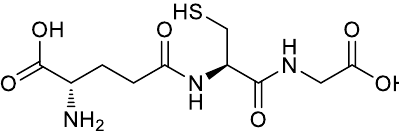
Figure 7. Structure of glutathione (GSH).